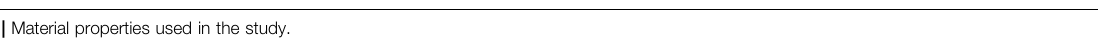
TABLE 1 | Material properties used in the